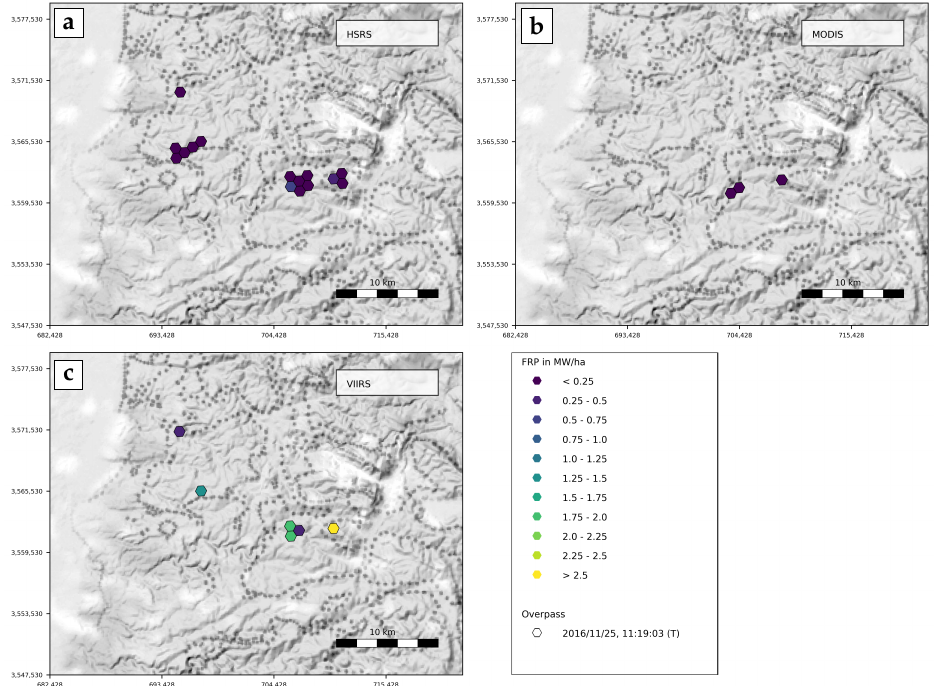
Figure 4. FireBIRD active fire data (derived using the MWIR method) and reference data for a fire event in Palestine and Israel, November 2016. ( a ) shows active fires derived from a single FireBIRD/HSRS overpass (25 November 2016), pigmented by FRP. ( b ) shows MODIS active fire data of the Aqua/Terra overpass in closest temporal vicinity to the respective FireBIRD overpass. ( c ) shows VIIRS active fire data of the Suomi-NPP overpass in closest temporal vicinity to the respective FireBIRD overpass. Background: Stamen/OpenStreetMap shaded terrain map, shown in gray